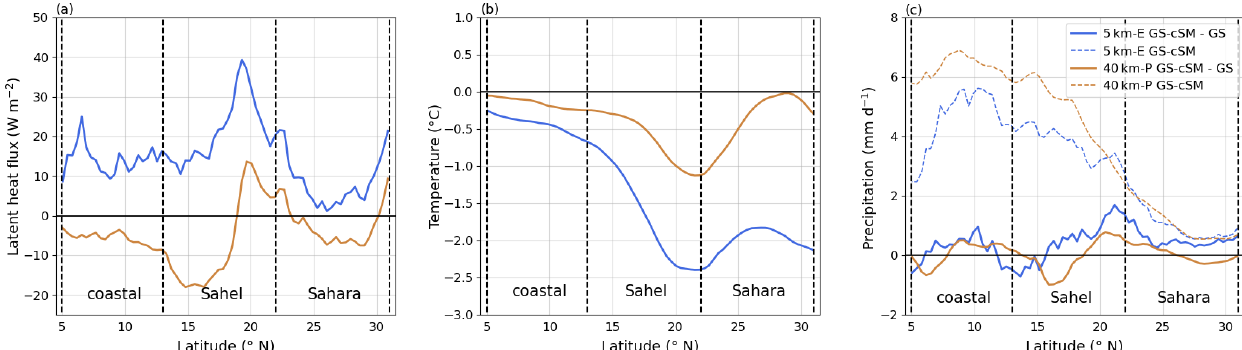
Figure 12. Difference of the JAS mean meridional distributions of latent heat flux (a) , 850hPa temperature (b) , and precipitation (c) between the GS-cSM and the GS simulations (solid lines) as well as for the GS-cSM simulation (dashed lines in panel c ) for the 5km-E (blue lines) and the 40km-P (orange lines), respectively. The vertical black dashed lines indicate the boarders of the coastal, the Sahel, and the Sahara region outlined in Fig.